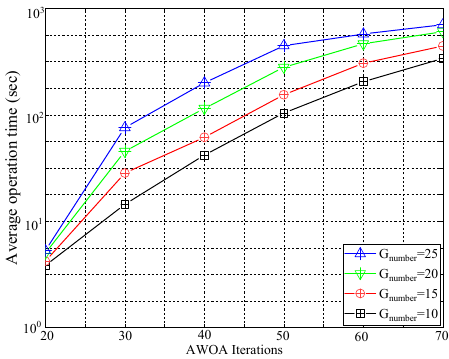
Figure 14. Comparison of e×ecution time.